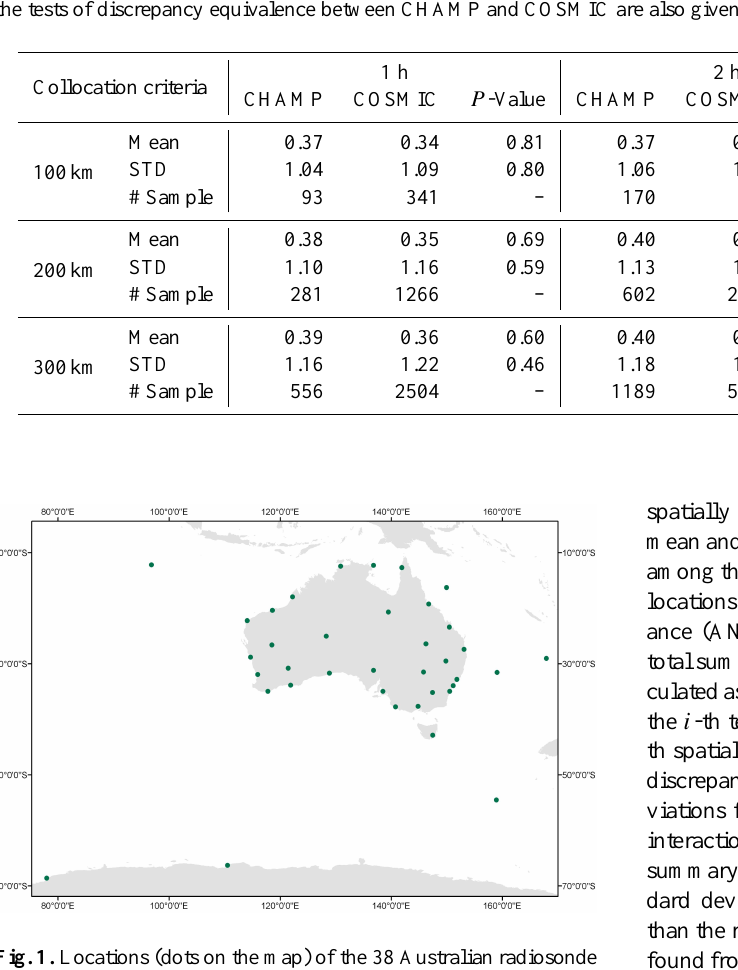
Table 1. Means, standard deviations (STD) and the number of pairs (# Sample) of the temperature ( ◦ C) discrepancies between radiosonde and RO data using different collocation criteria (i.e. 100, 200 and 300km radial buffers with 1, 2 and 3h temporal buffers); Radiosonde data are from 38 Australian observational meteorological stations and they were compared with RO retrieved temperature profiles from both CHAMP (between 2001 and 2008) and FORMOSAT-3/COSMIC (between 2006 and 2009) data over the Australasian region. P -values for the tests of discrepancy equivalence between CHAMP and COSMIC are also given separately for the mean and STD.